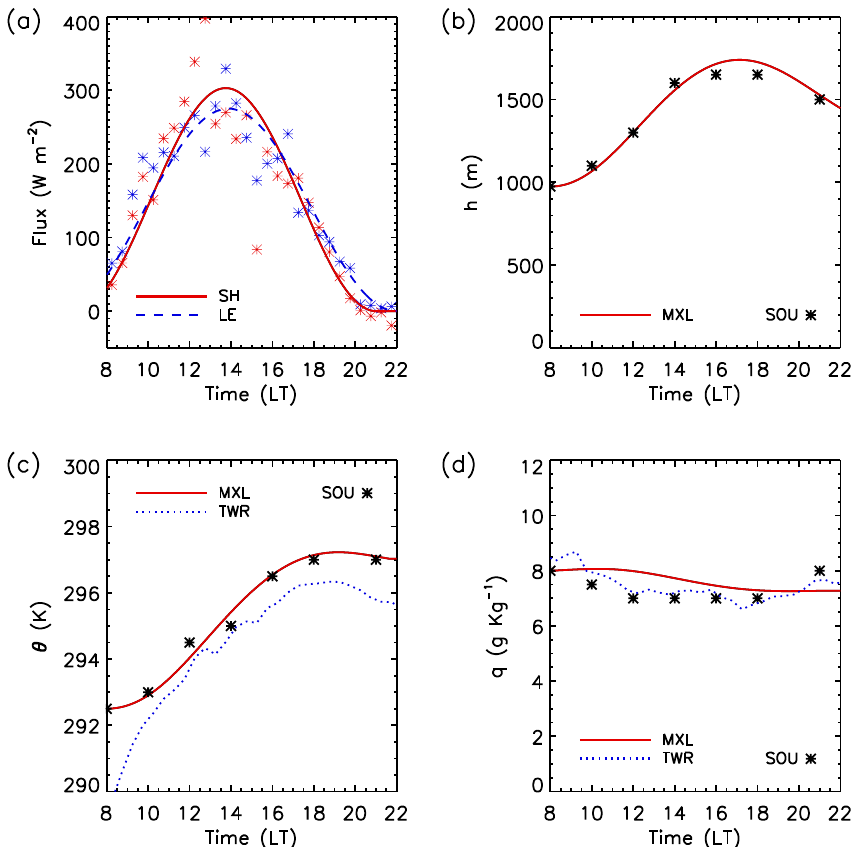
Fig. 15. Applied surface forcings (a) and simulated evolution of ABL characteristics (b, c, d) by the MXL model. The ABL characteristics include the boundary layer height (b) , potential temperature (c) and specific humidity (d) . In (a) , the lines represent the sensible heat flux, SH, and latent heat flux, LE, surface forcings applied to the model and the asterisks represent the corresponding observations from the tower. In (b, c, d) , solid red lines depict model results and the asterisks symbolize radiosonde observations. Tower observations (TWR) are expressed by dotted blue lines.